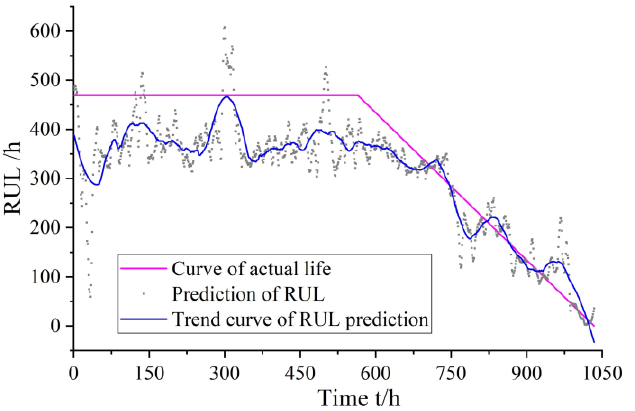
Figure 11. RUL prediction of gear pump 4 based on JITL method proposed in this paper.